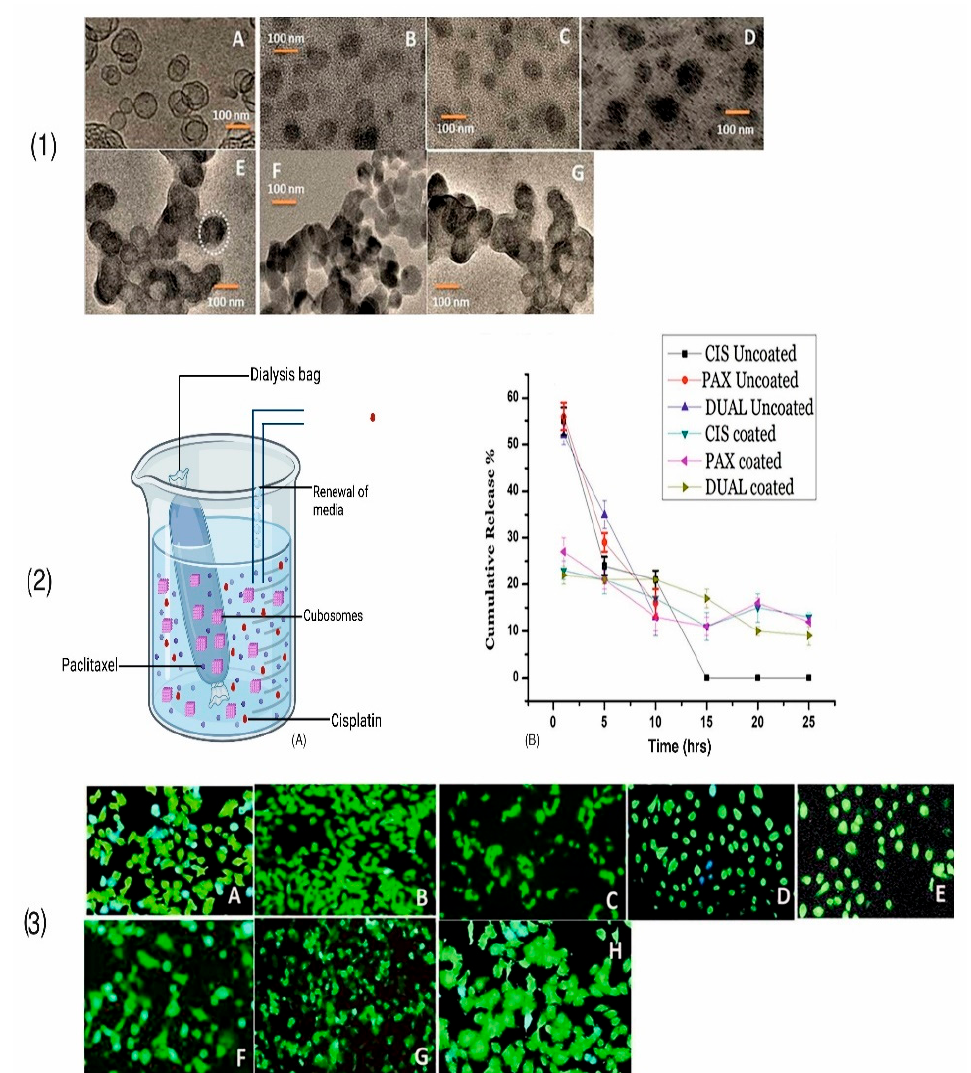
Figure 3. Illustration of ( 1 ) morphological analysis of ( A ) blank cubosomes, ( B ) uncoated CIS, ( C ) uncoated PAX, ( D ) uncoated DUAL, ( E ) coated CIS, ( F ) coated PAX and ( G ) coated DUAL cubosomes; ( 2 ) in vitro drug release studies ( A ) assembly and ( B ) comparative results of drug release; and ( 3 ) Cell viability studies on exposure of Human hepatoma HepG2 cells to ( A ) PBS blank cubosomes, ( B ) control cubosomes, ( C ) coated CIS, ( D ) uncoated CIS, ( E ) coated PAX, ( F ) uncoated PAX and ( G ) coated DUAL, ( H ) uncoated DUAL cubosomes. Reproduced from Zhang et al., 2020 [69]